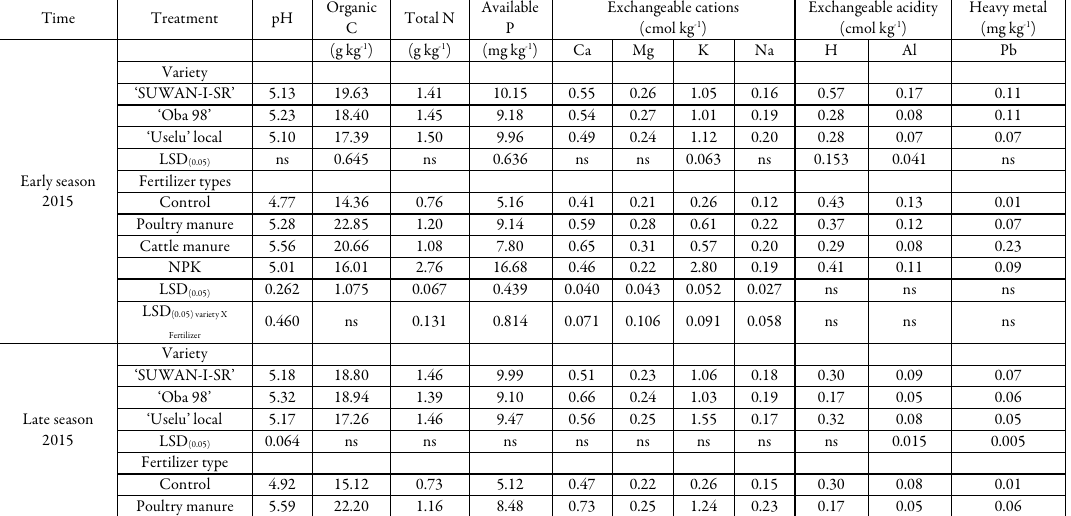
Table 4. Effects of maize variety and fertilizer type on the postharvest soil chemical properties Organic Time Treatment pH